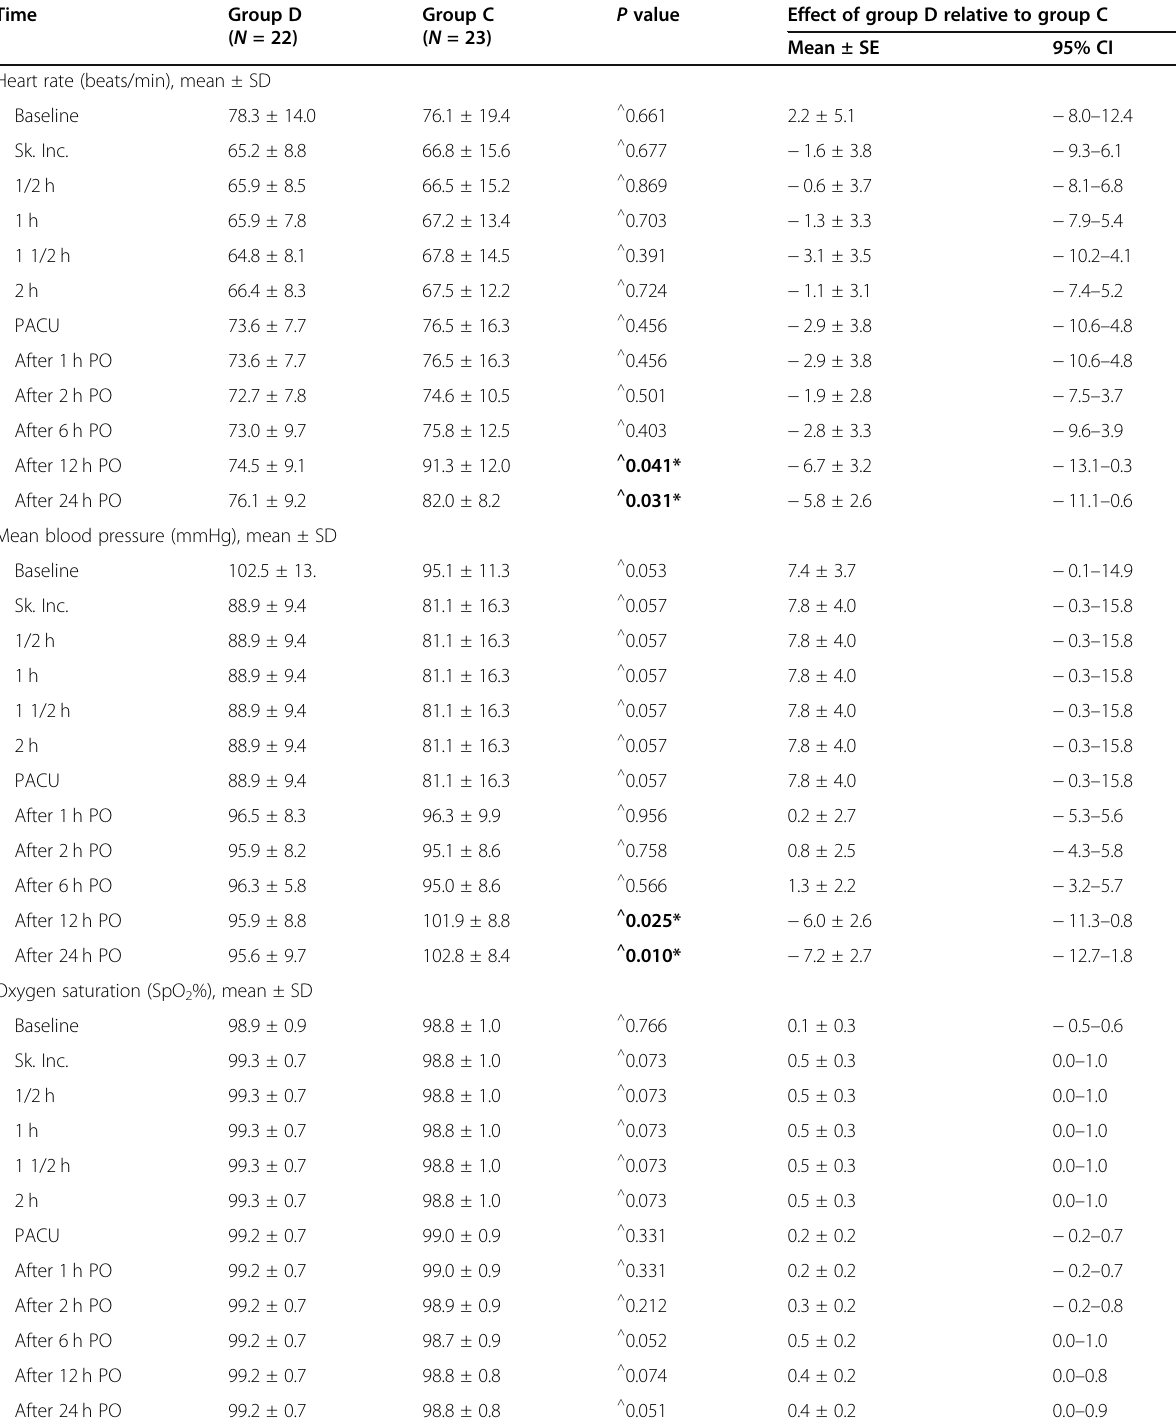
Table 2 Comparison between the C group and D group according to HR, MAP, and SpO 2 P value Effect of group D relative to group C Time Group D Group C ( N = 22) ( N = 23) Mean ± SE 95% CI Heart rate (beats/min), mean ±